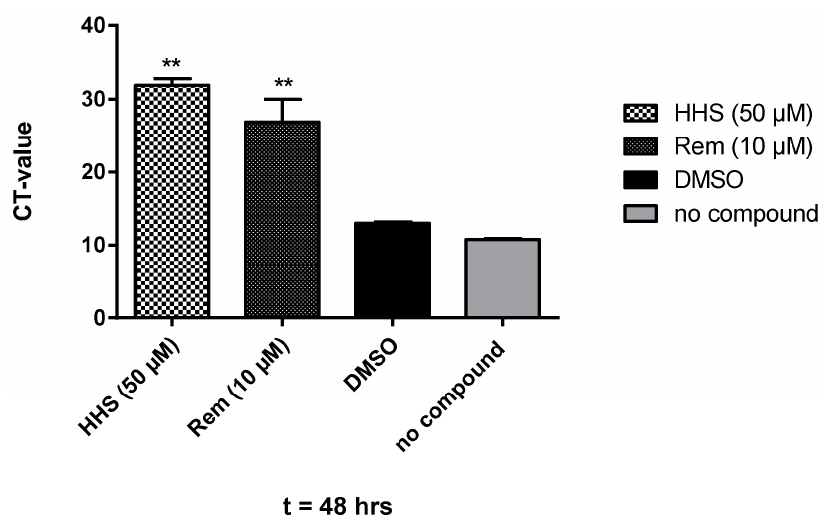
Figure 3. Treatment of Vero E6 cells with HHS (50 µ M), remdesivir (10 µ M) and DMSO (1% in medium). Compounds were present pre- and during infection with SARS-CoV-2 and during incubation. After 48 h, RNA was extracted, and the viral copy numbers were quantified via qRT-PCR. Values represent the CT values (means ± SD) of five determinations. Asterisks (**) indicate significantly different ( p < 0.01) in comparison to no compound (non-parametric unpaired t -test).